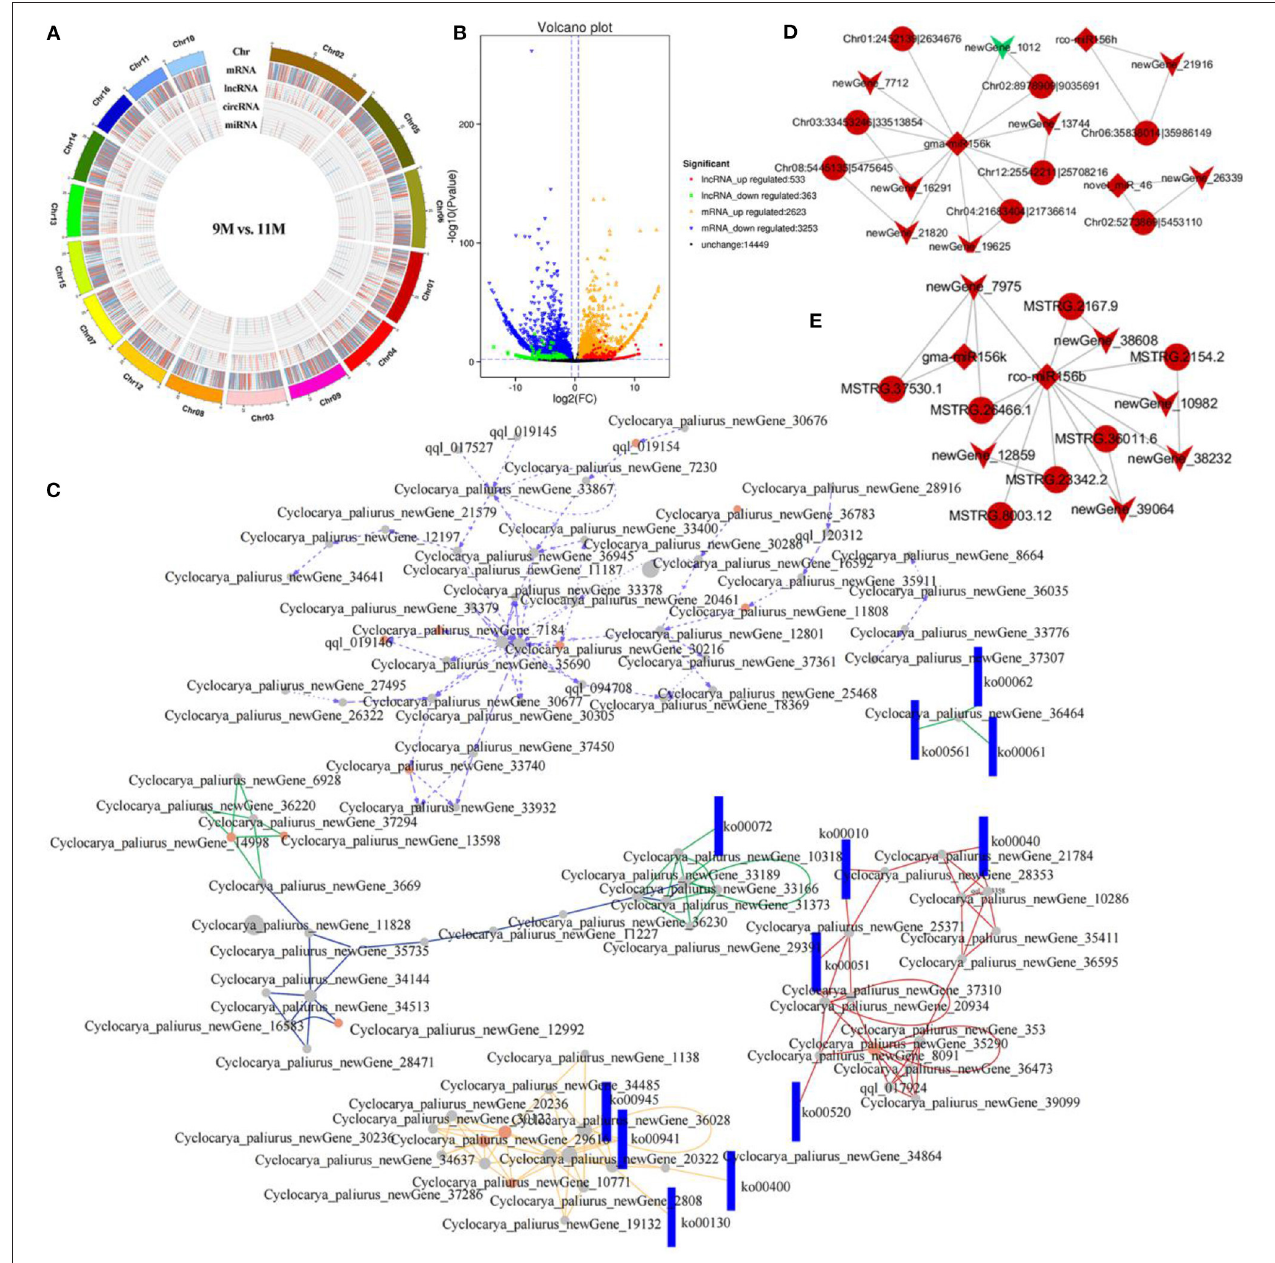
FIGURE 5 | Coexpression and ceRNA network analysis. (A) Circos diagram of DE-RNAs in the 9M_vs_11M group. (B) Volcano diagram of the DE-lncRNAs and DE-mRNAs in the 9M_vs_11M group. (C) CeRNA networks in the 10M_vs_11M group. Dots and rectangles represent genes and pathways, respectively. The colors of different lines represent relationships from different paths. (D) CircRNA-miRNA-mRNA network. Circles, diamonds, and arrows represent circRNA, miRNA, and mRNA, respectively. (E) LncRNA-miRNA-mRNA network. Circles, diamonds, and arrows represent lncRNAs, miRNAs, and mRNAs, respectively.